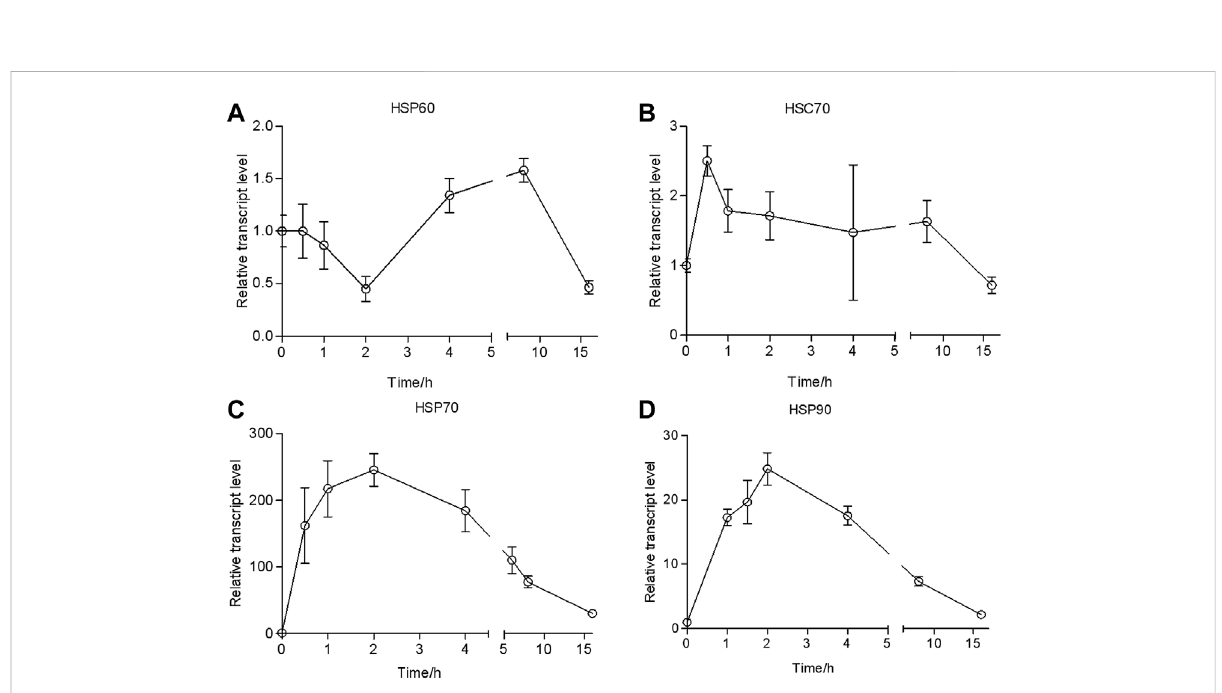
FIGURE 3 Relative transcript levels of HSP60 (A) , HSC70 (B) , HSP70 (C) , and HSP90 (D) at different times with 43 ° C treatment. The values from two independent replicates are shown as the mean ± SD, as analyzed by the 2 − △△ CT